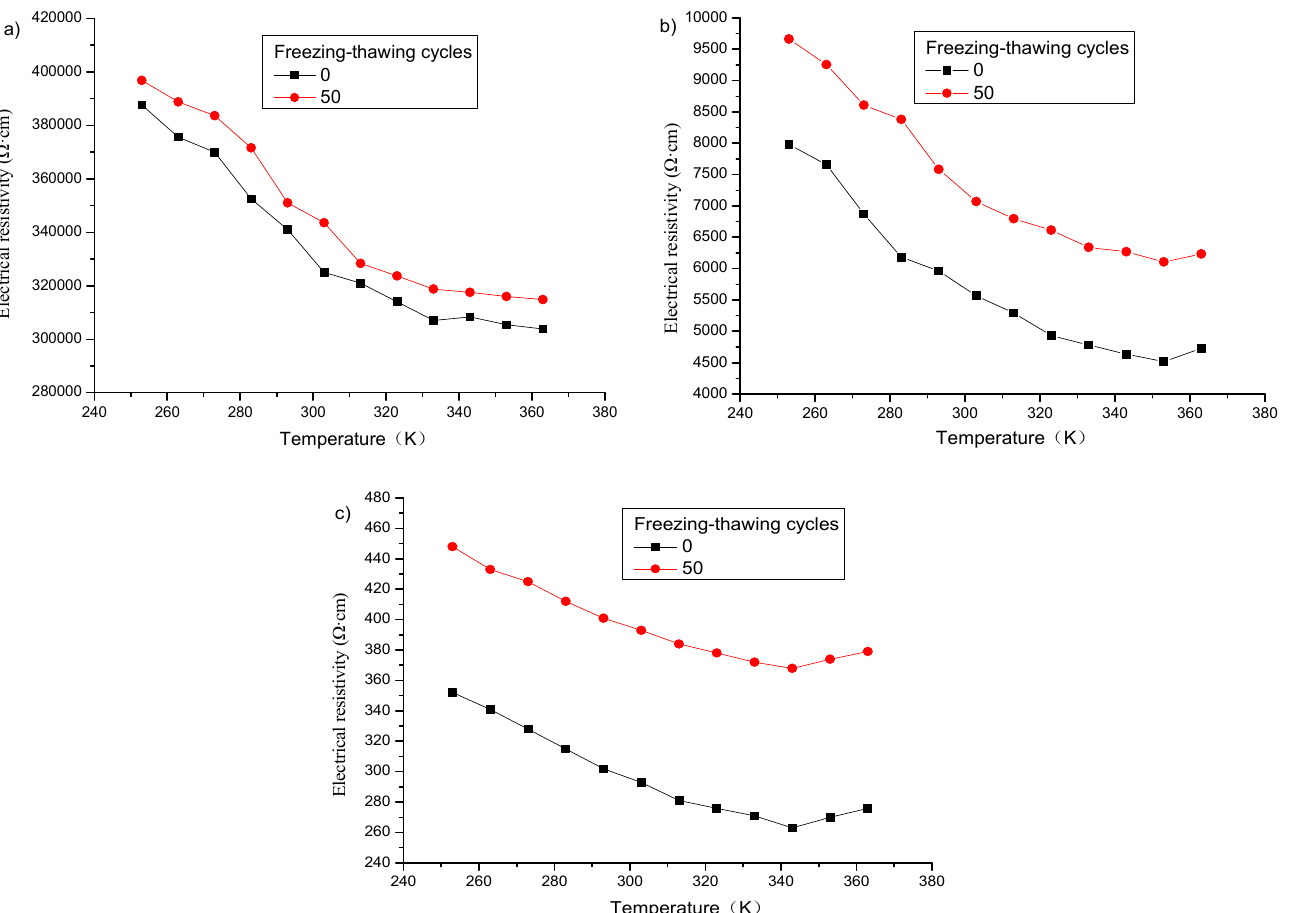
Figure 14. Influence of temperature on electrical resistivity of specimens with different graphene contents before and after freezing and thawing: ( a ) 1%; ( b ) 2%; ( c ) 3%.